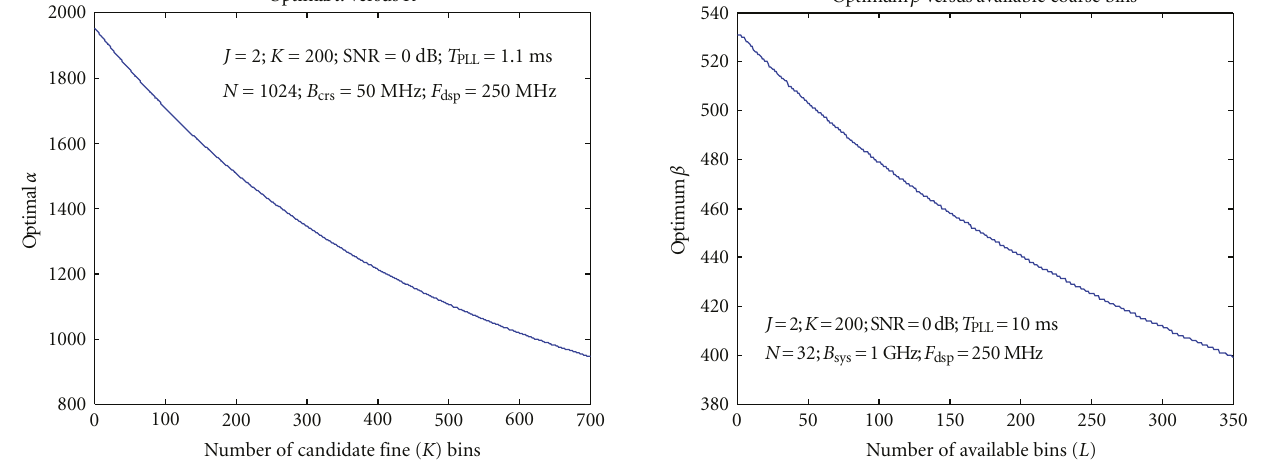
Figure 5: Optimal α versus number of available fine bins.